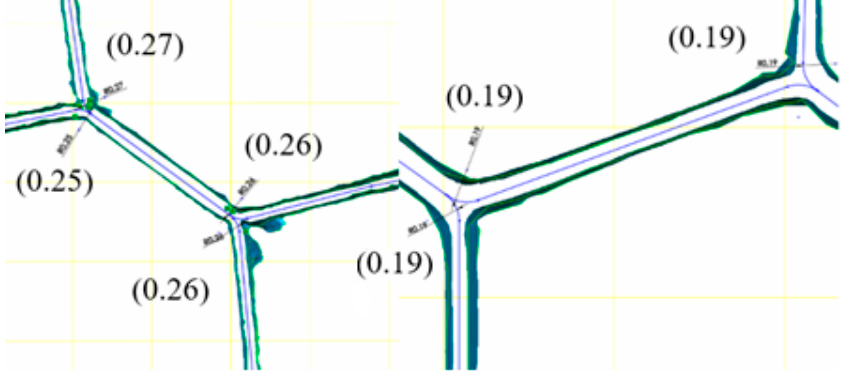
of the walls near the joints. Exemplary measurement results are shown in Figure 6.